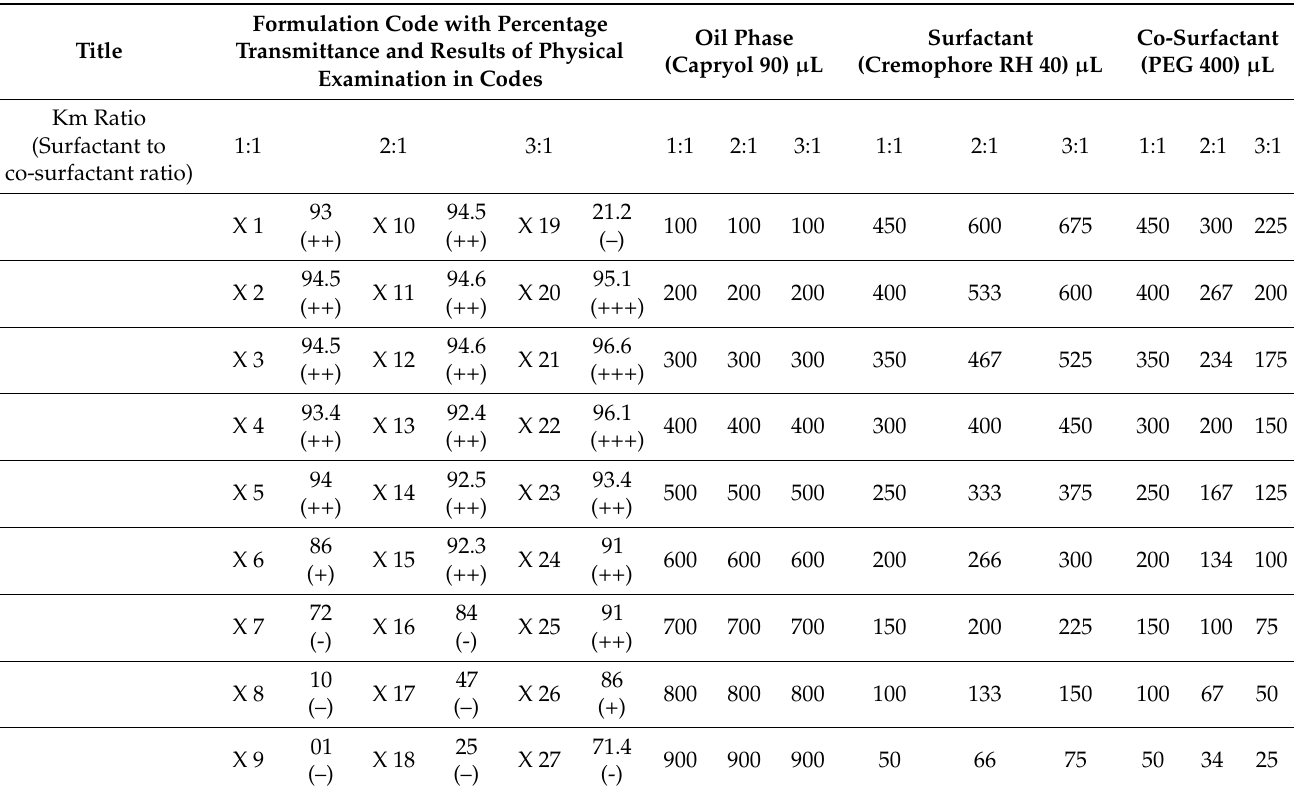
Table 6. Composition of different SNEDDS formulations (27) using different excipient ratios and results of physical examination with percentage transmittance. (Good emulsions with % transmittance > 95 = +++, Good emulsions with % transmittance > 90 = ++, Good emulsions with % transmittance > 85 = +, Bad emulsions with % transmittance < 85 and > 70 = -, Poor dispersions =